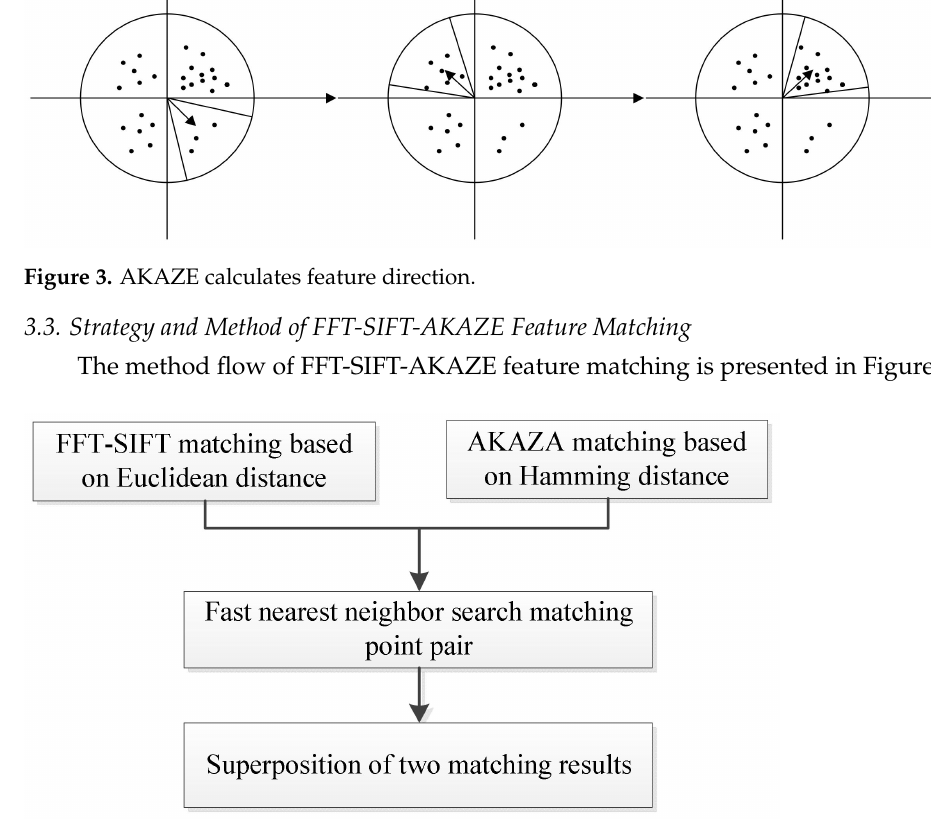
Figure 4. Fusing process of multiple feature matching